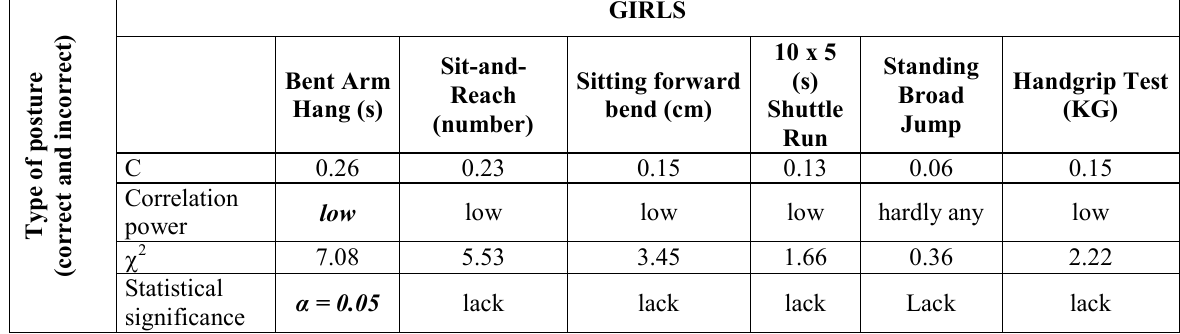
Correlations occurring between the posture (correct and incorrect) and selected tests of the EUROFIT physical fitness test in the boys involved in the study